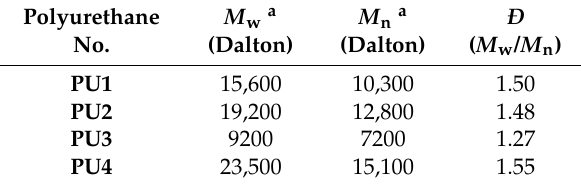
Table 4. The average molecular weights and dispersities determined by GPC/SEC a . Polyurethane